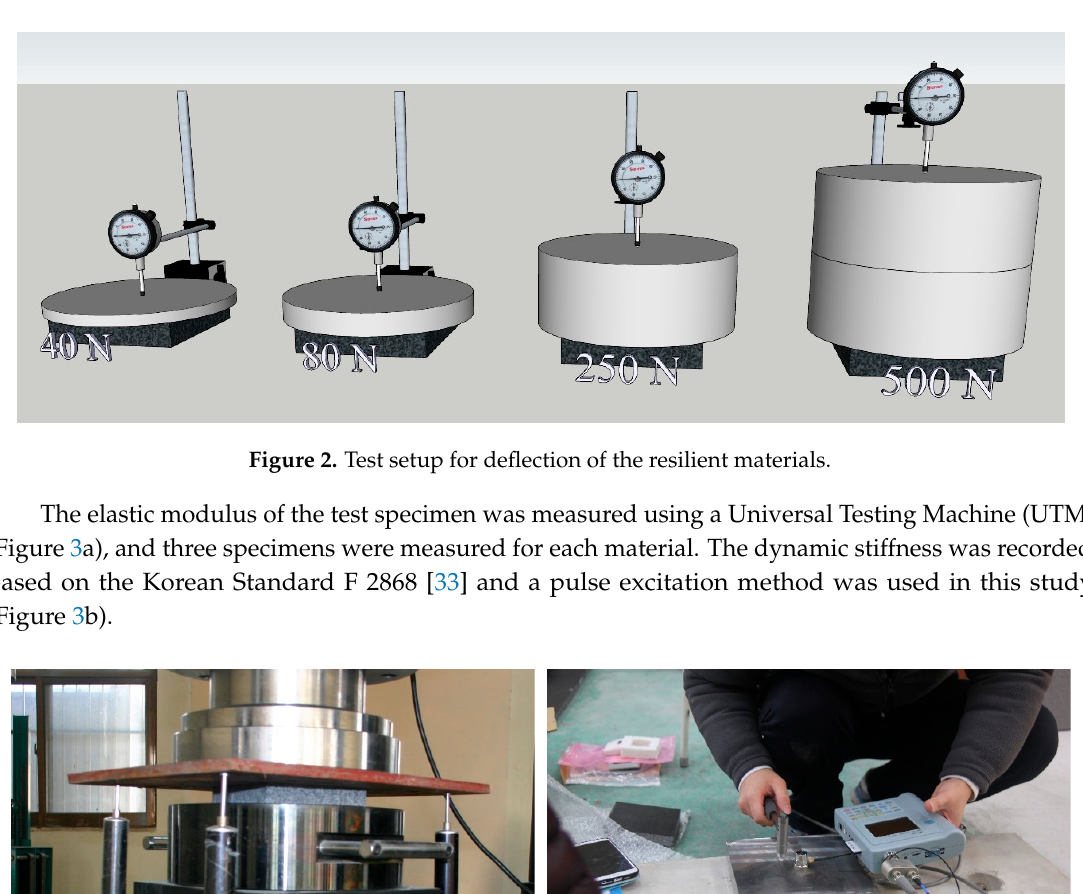
Table 1. Details of specimens.